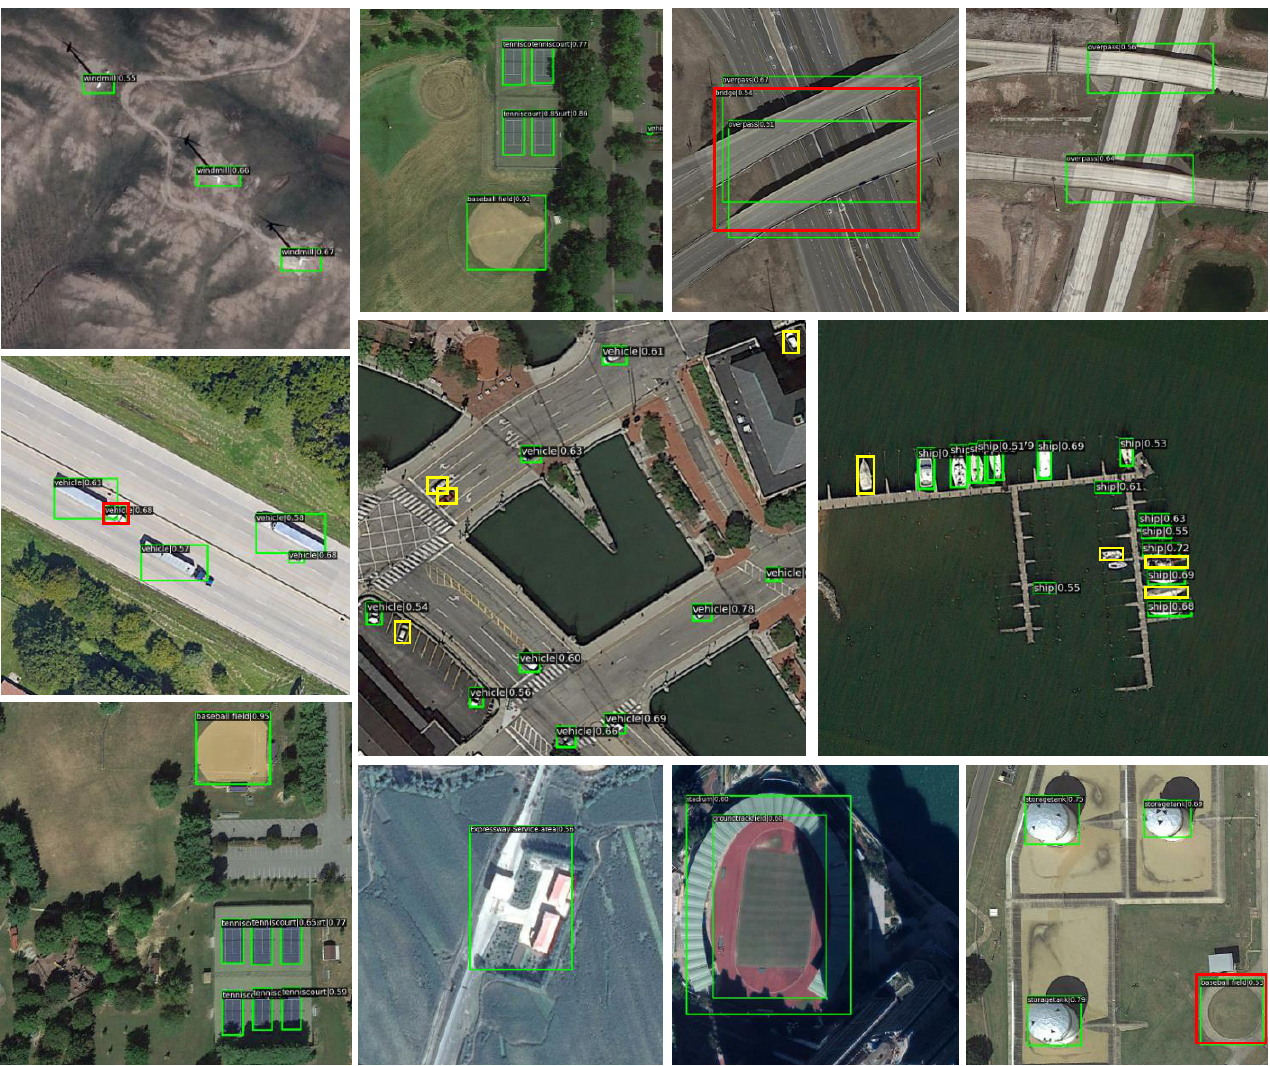
Figure 7. Qualitative examples on DIOR by EFNet. The TPs, FPs, and FNs are indicated by green, red, and yellow boxes,